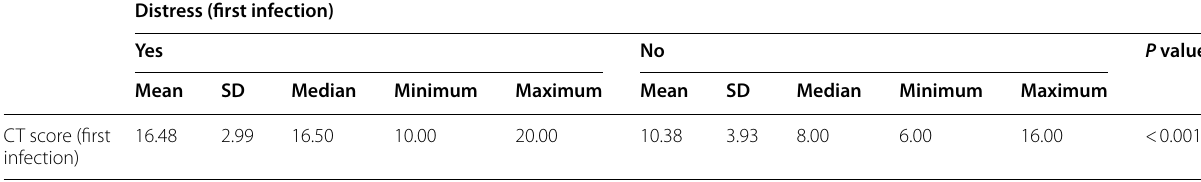
Table 7 Relation between distress and CT severity score (during first infection) Distress (first